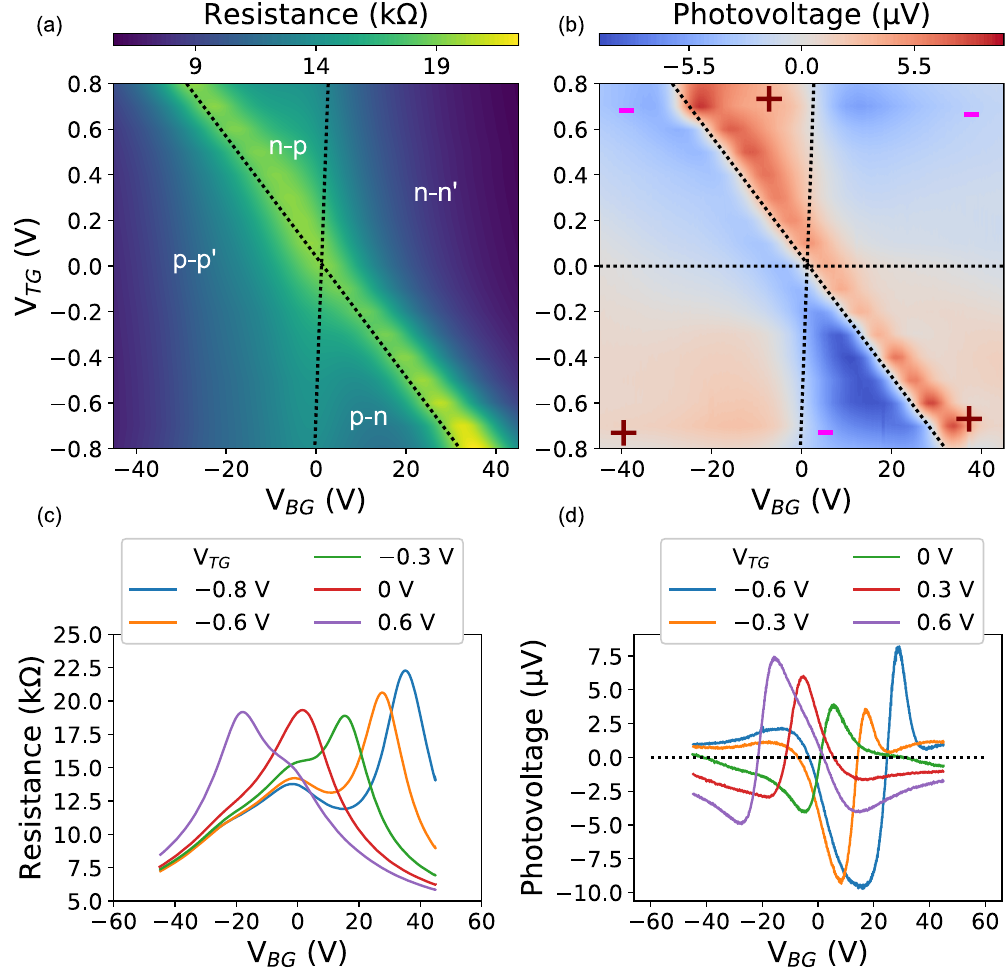
Figure 3. Photovoltage and resistance measurements at 120 K. To change the top gate voltage, the device is warmed to 273 K and the top gate voltage is adjusted and allowed to stabilize for half an hour before the device is cooled down to 120 K. (a) The measured resistance as a function of both gates. The dotted lines indicate the charge neutrality peaks of the two regions and the polarity of the exposed and covered regions is indicated. (b) The corresponding photovoltage at the junction measured simultaneously with the resistance. There is a clear signature of photothermoelectric effect indicated by the sixfold pattern 29 . Six regions with alternating positive and negative signs are indicated by plus and minus signs and dotted lines that separate the six regions have been drawn. (c) Slices of the resistance data in Fig. 3(a) exhibit two Dirac peaks. (d) Slices of the photovoltage with multiple zero